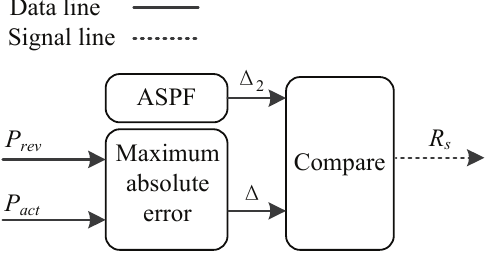
Figure 4. The principle of Updating judgment